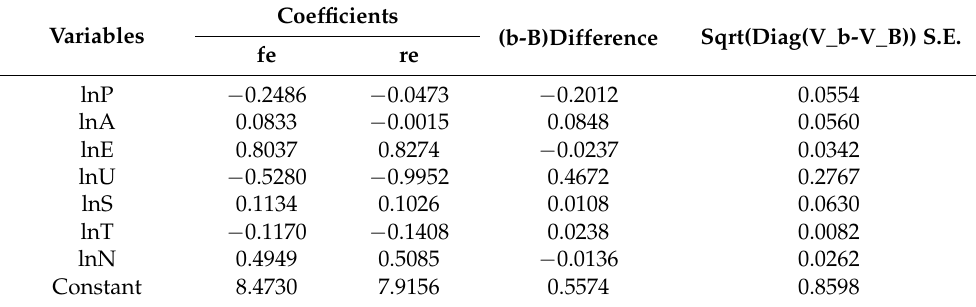
Table 5. The results of the Hausman